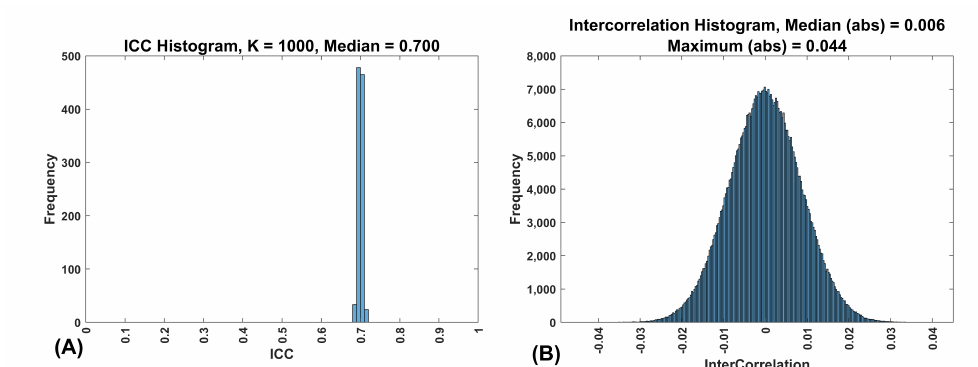
Figure 2. ( A ) Frequency histogram of ICCs for 1000 features with an ICC Target = 0.7. This was from a synthetic data set with 10,000 subjects. ( B ) Frequency histogram of correlations between 1000 features for 10,000 subjects, two sessions, with an ICC Target = 0.7. Note that the median and maximum are of the absolute value of the